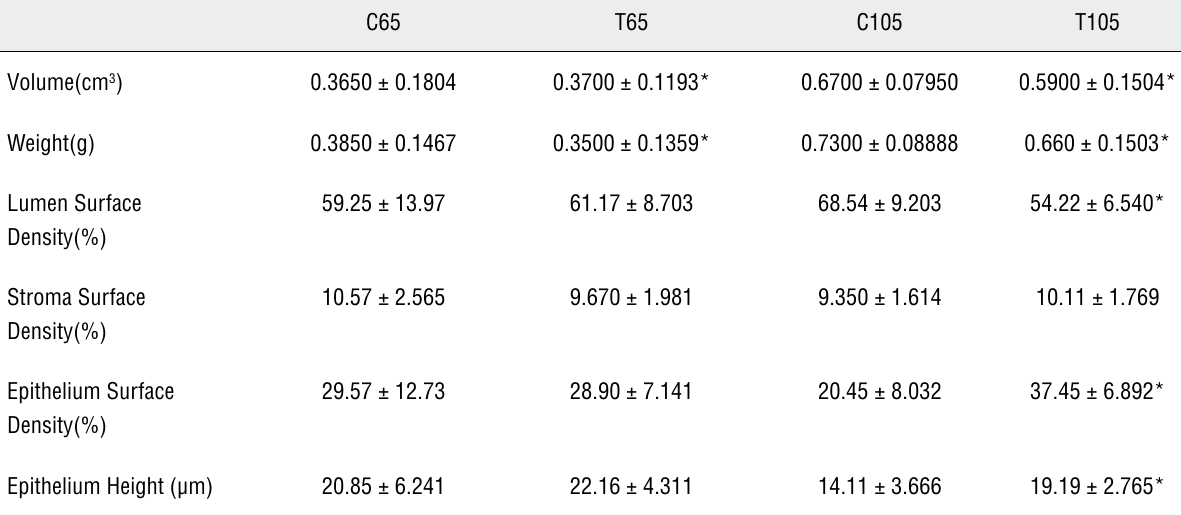
Table 1 - The table shows the numerical values with mean and standard deviation (sD) of the structures studied in the rat prostate ventral lobe treated with anabolic androgenic steroids. C105 - control rats, with 105 days of age; C65 - control rats with 65 days of age, injected only with the vehicle (peanut oil); T105 - treated rats, with 105 days of age and T65 - treated rats with 65 days of